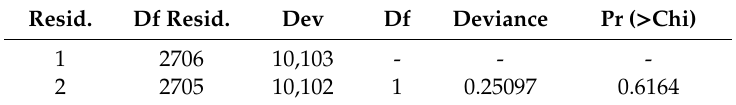
Table 18. Comparison of the variables camera type and device used by ANOVA.